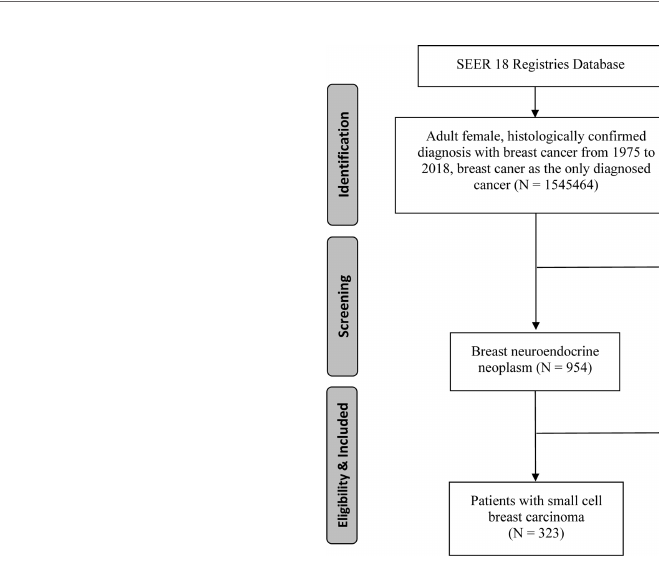
FIGURE 1 | Flow diagram of patients enrollment in this